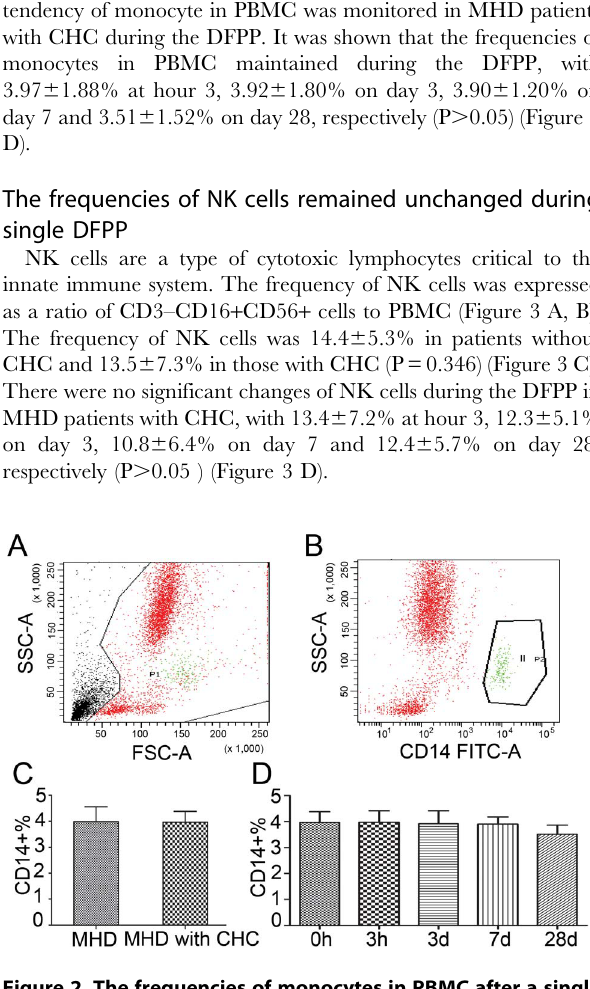
Figure 2. The frequencies of monocytes in PBMC after a single DFPP. A, B. Monocyte was expressed as CD14 + cells in PBMCs. C. The frequencies of monocytes in MHD patients with CHC compared to those without CHC. D. The frequencies of monocytes in MHD patients with CHC during the DFPP.